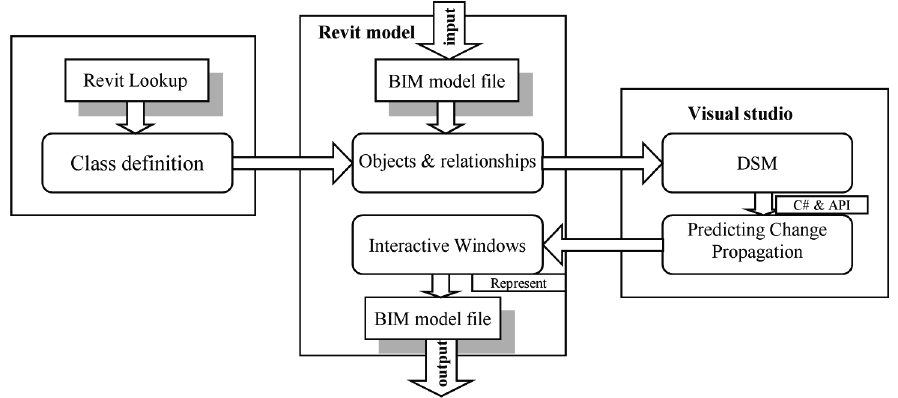
Fig. 12. Integration of DSM with BIM